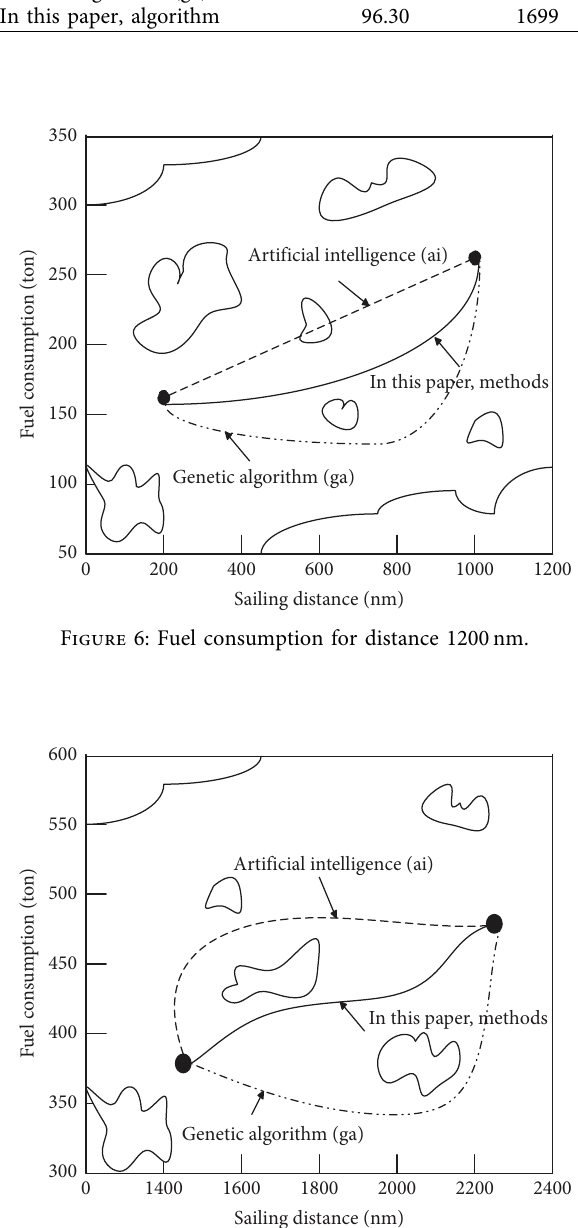
Figure 7: Fuel consumption for distance 2400nm.